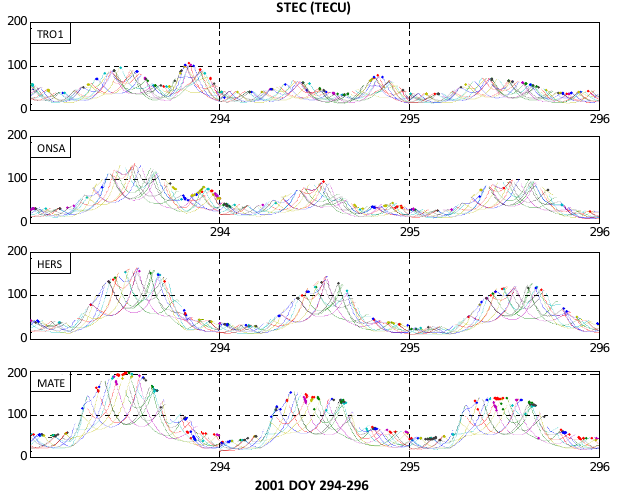
Fig. 6. Ion2 (m) for GPS L1 (Ion2L1) for the observation stations on DOY 294‐296 in 2001.